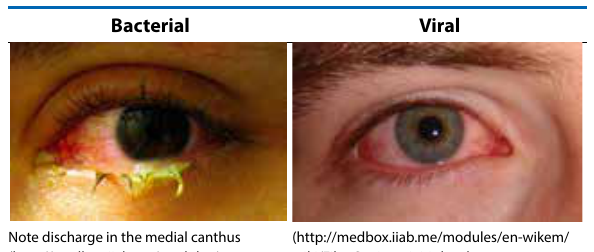
Figure 1: Conjunctivitis Bacterial Viral